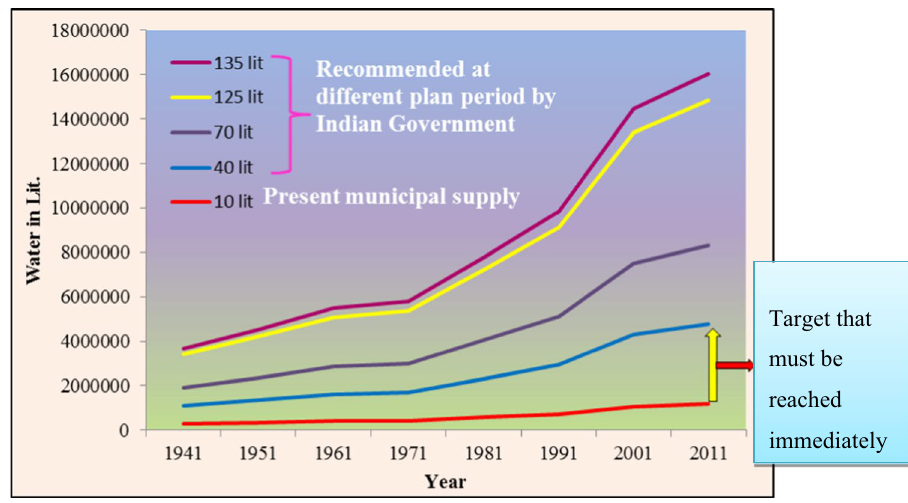
Fig. 8 Increasing water demand over time 1997 Source :